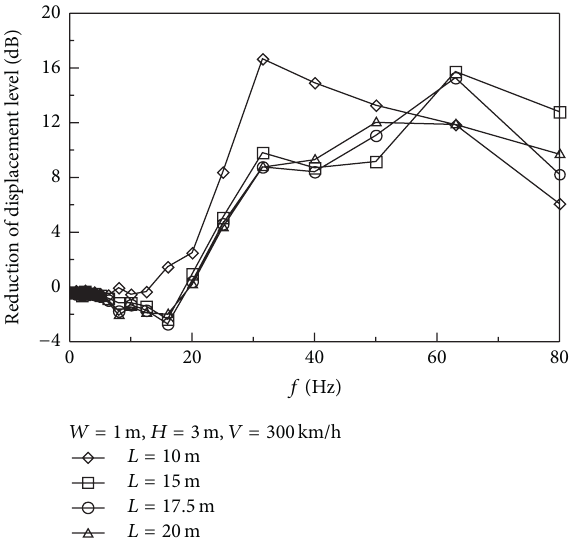
Figure 15: Influence of trench location on RDL.